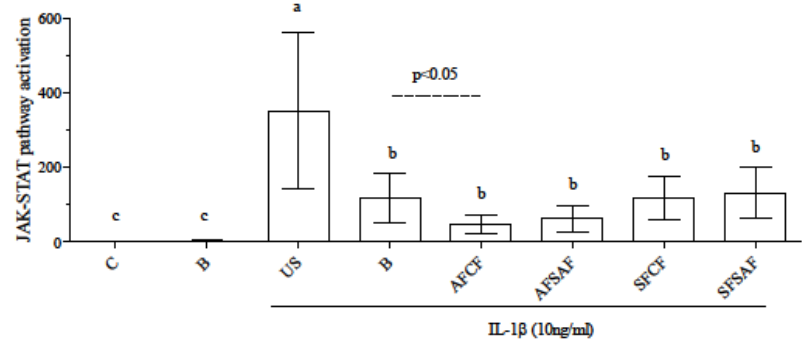
Figure 6. JAK-STAT pathway activation in HEK-Blue™ IL-6 cells exposed to Caco-2 cells media. Data are means ± SD of at least 4 samples derived from 2 independent experiments, and are expressed as the percentage of the value obtained in control cells (assigned as 1). Different letters indicate statistical significance ( p < 0.05). C = control, B = supplemented with blank digesta; US = unsupplemented; AF = ancient flour; SF = standard flour; CF = conventional fermentation; SAF = sourdough obtained from ancient flour; SSF = sourdough obtained from standard flour.